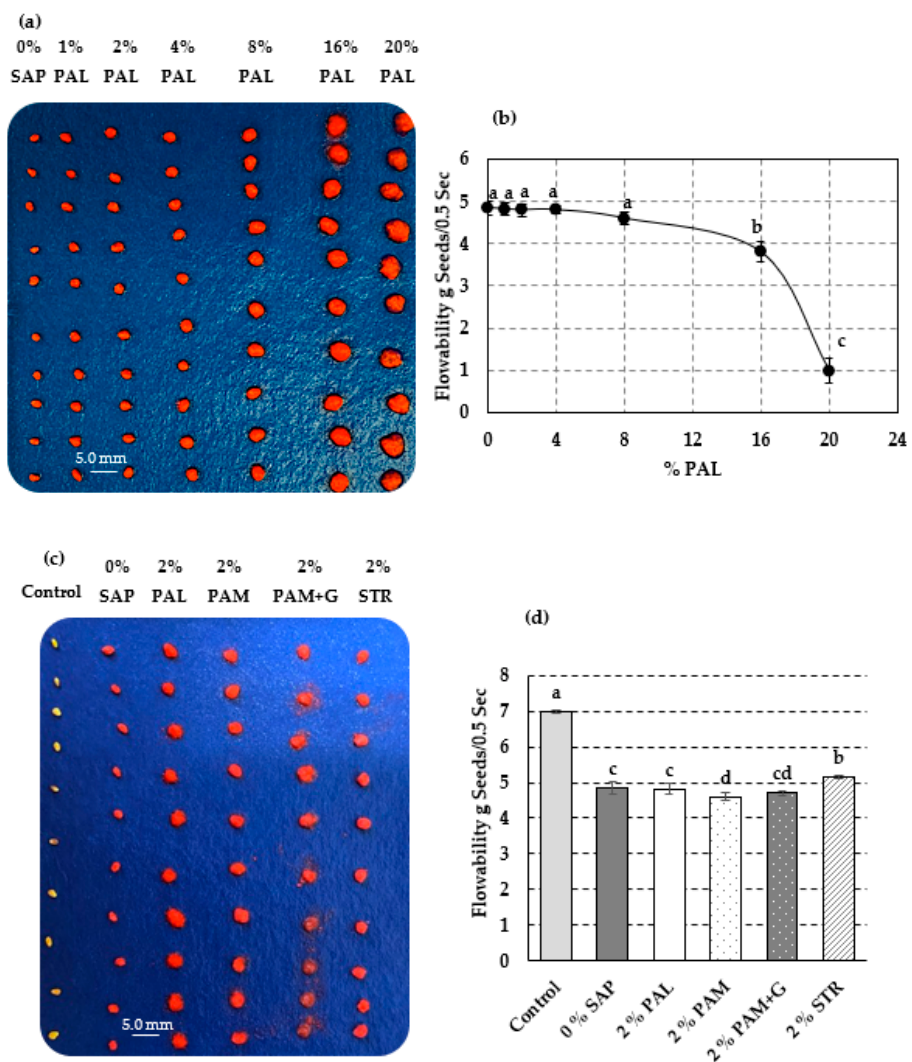
Figure 5. Effect of increasing PAL% in coating materials on coated seeds’ ( a ) water absorbency and ( b ) flowability performance. Comparison of 2% SAP-coated seeds’ ( c ) water absorbency and ( d ) flowability performance with the coated seeds without SAP and the non-treated control red clover seeds. Different letters above error bars indicate significant differences among treatments ( p < 0.05).